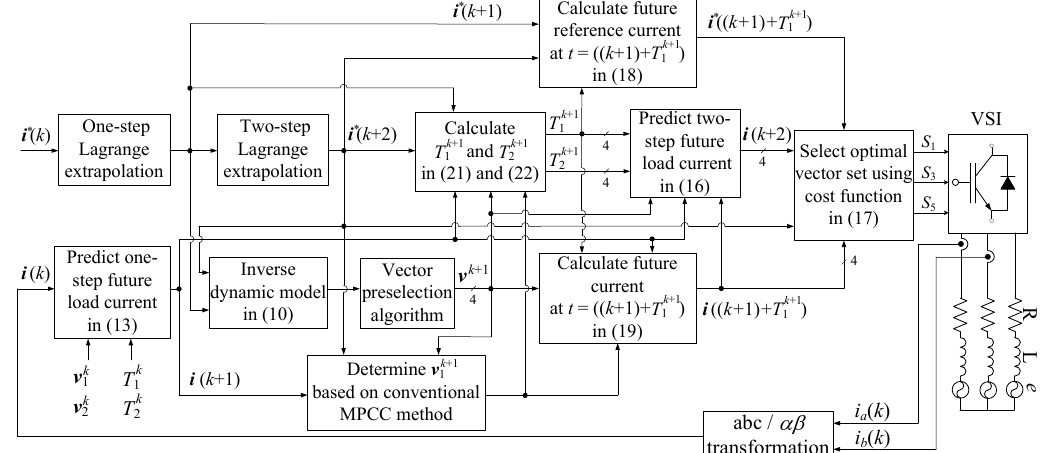
Figure 4. Diagram of the proposed method.